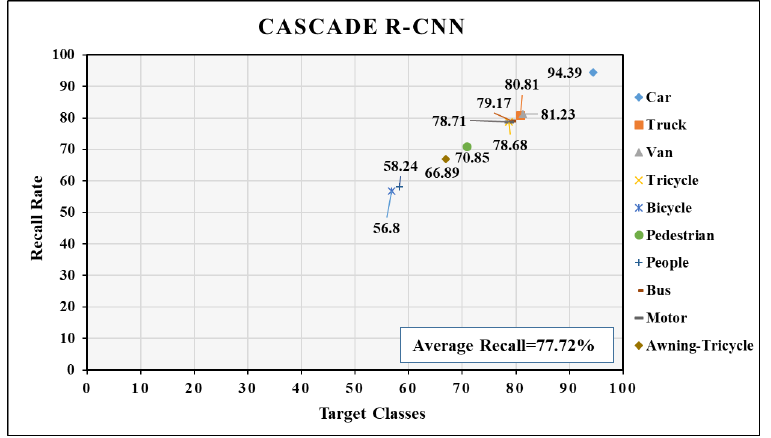
Figure 13. Recall rate of Cascade R-CNN approach based on different target